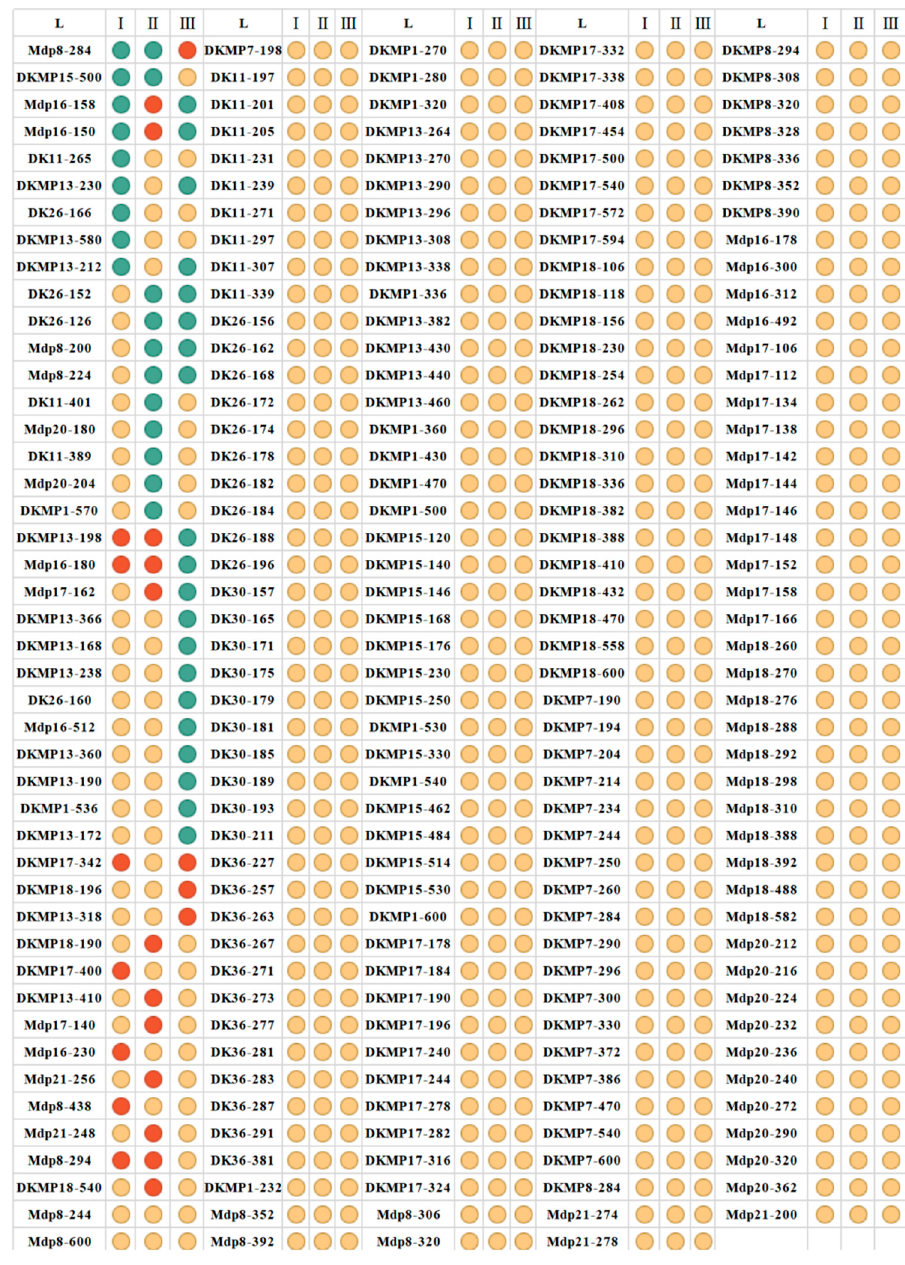
Figure 9. Distribution of alleles among clusters per locus. The pie chart with different color parts represents the different allele numbers of each locus among clusters, and the green pie represents zero allele of the loci existing in the cluster, the red pie represents one allele of the loci existing in the cluster, and the yellow pie represents more than one allele of the loci existing in the cluster.